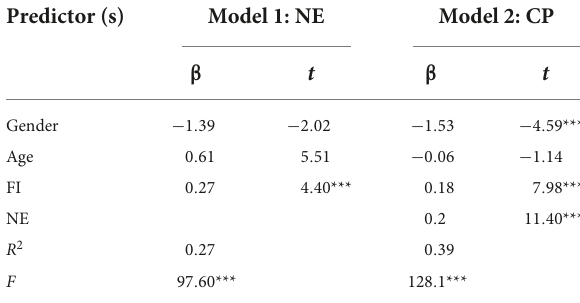
TABLE 3 Testing the moderated mediation effect of neuroticism on cyberbullying